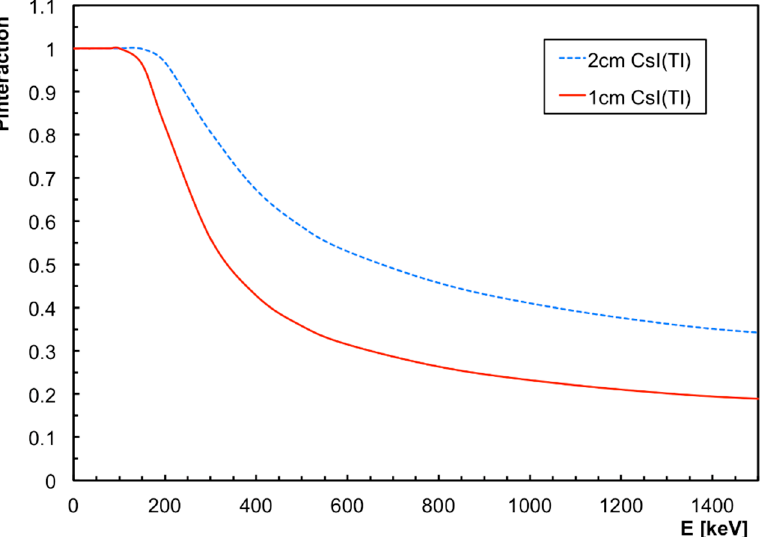
Figure 1. The probability of the interaction of a gamma ray in 1- and 2-cm-thick CsI(Tl) as a function of its energy.